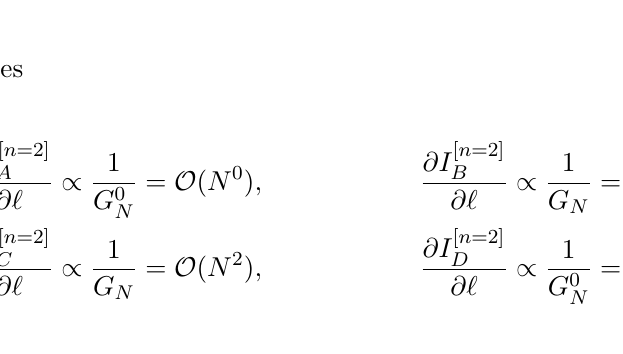
Figure 8 . Mutual Information of S B and S C Figure 9 . Mutual Information of S B and S C phases as a function of strip length ‘ . The solid phases as a function of separation length x . The lines correspond to I [ n =2] whereas the dashed solid and dashed lines correspond to I [ n =2] B lines corresponds to I [ n =2] . The red, green and I [ n =2] respectively. The solid-red, solid-green, C C blue lines correspond to separation length x = dashed-red and dashed-green lines correspond 0 : 10, 0 : 15 and 0 : 20 respectively. In units GeV. to strip length ‘ = 0 : 1, 0 : 2, 0 : 5 and 0 : 6 respec- tively. In units